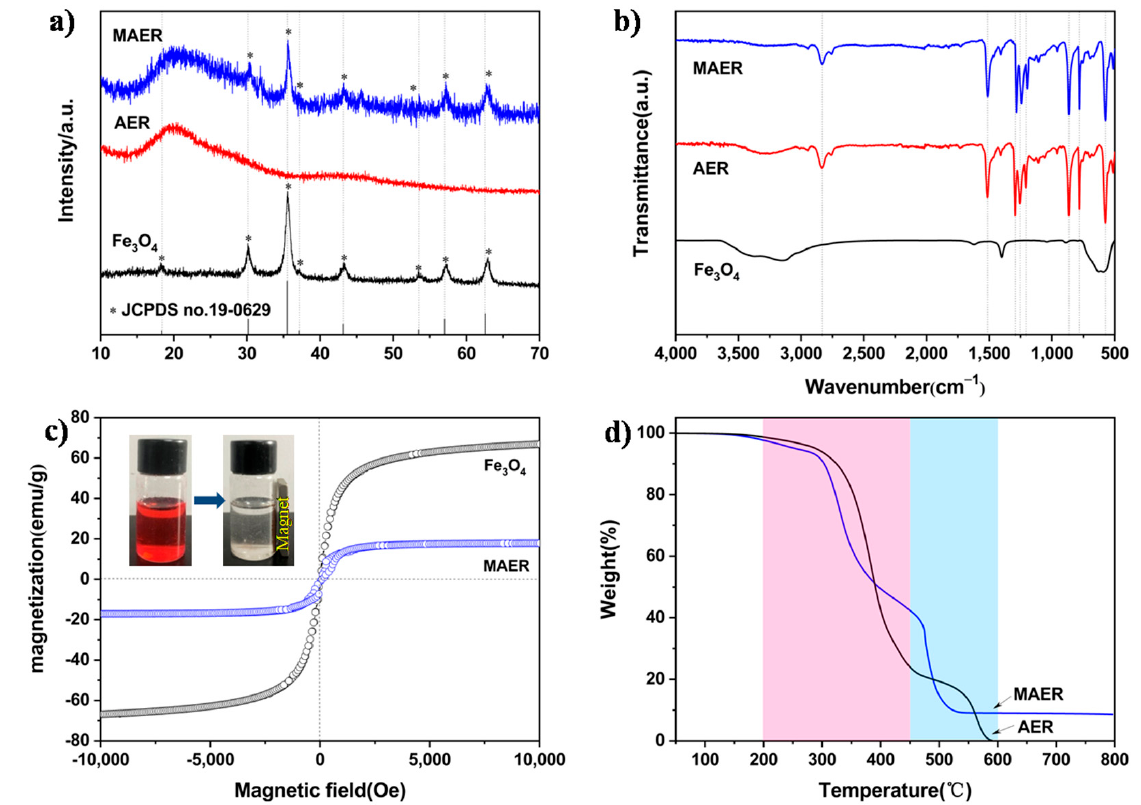
Figure 2. ( a ) XRD patterns, ( b ) FT-IR spectra, ( c ) the magnetic hysteresis loops (the inset shows the separation process), and ( d ) thermo gravimetric analysis (TGA) curves of the prepared materials.